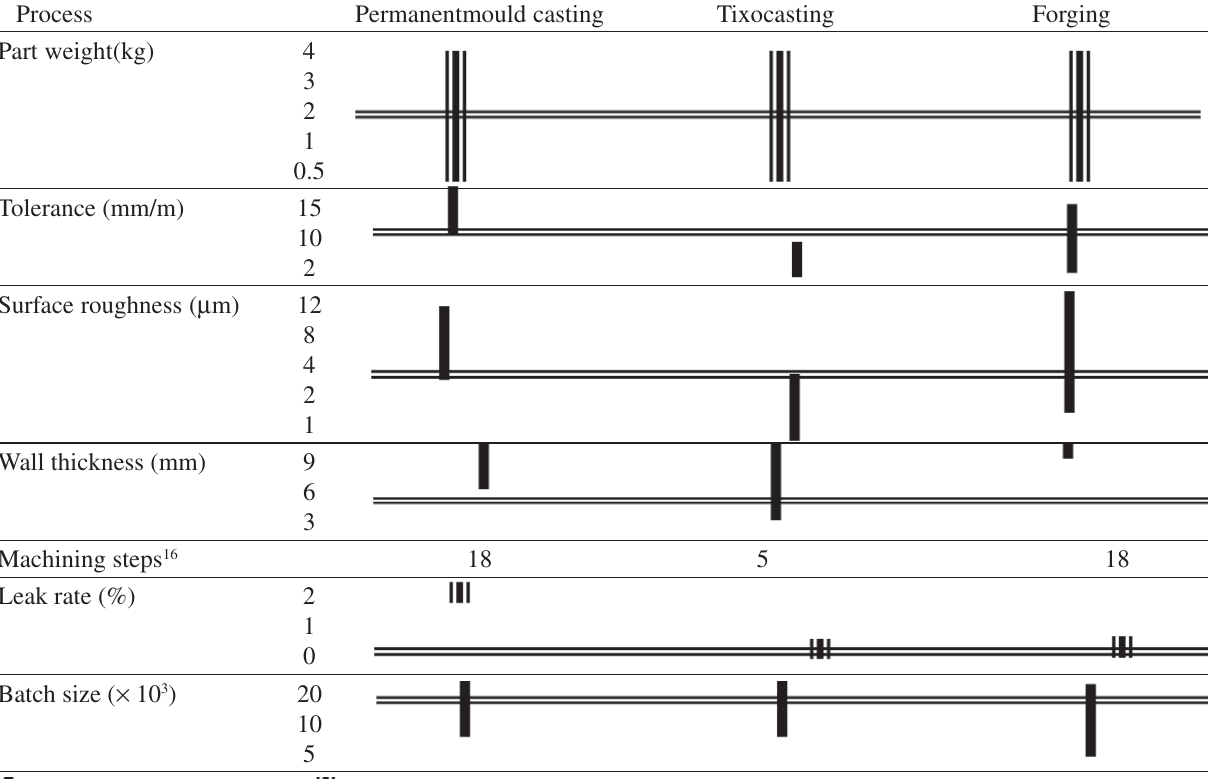
Table 4. Correlation of Processes, Product Specification and Properties